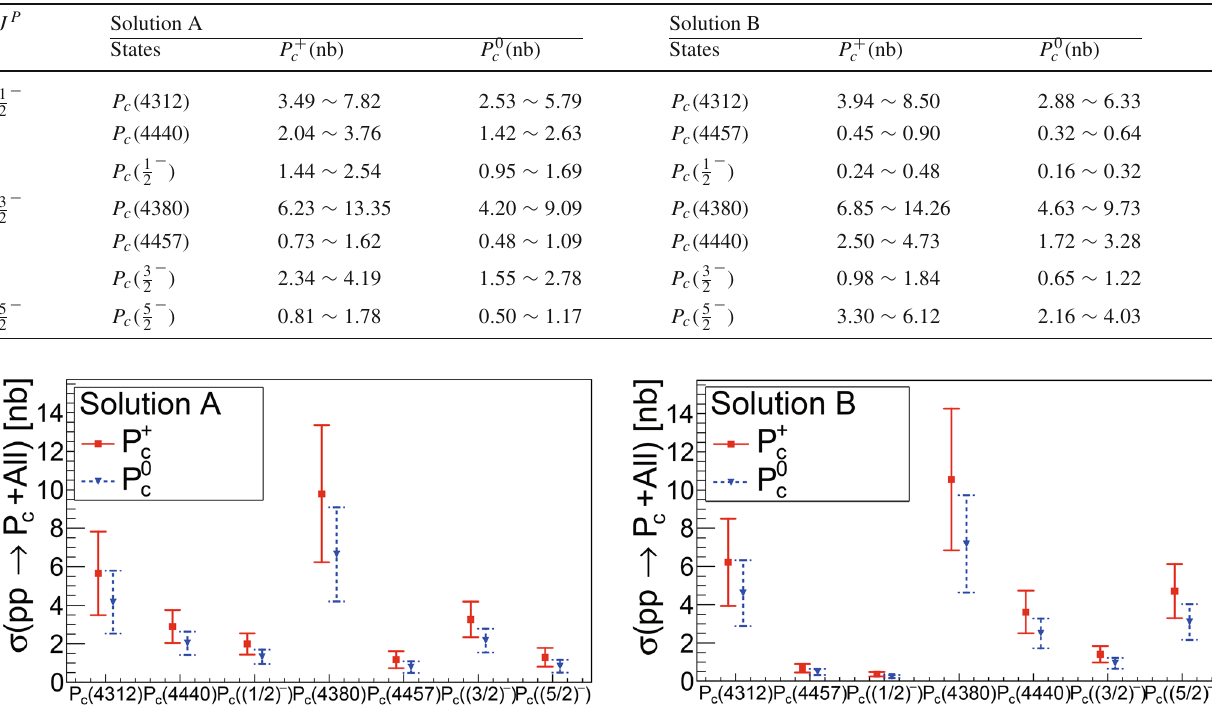
(cid:5) = 0 . 7 GeV, (cid:5) = 1 . 3 GeV and their average values. The difference Fig. 5 The cross section of the prompt production of the hidden charm √ s = 7 TeV. The red boxes and blue of uncertainties are mainly because of the k -dependence of the heavy pentaquarks in the pp collision at hadron pairs cross section, e.g. Eq. (9) in MC simulation. In our calcu- inverse triangles are for the charged pentaquarks P + c and the neutral lation, the k -dependence in each p T bin is evaluated numerically, but ones P 0 c , respectively. The left and right panels are for the solution A and solution B in the hadronic molecular picture. The lower limits, the not the simple k 2 upper ones and the central values correspond to the cross sections with